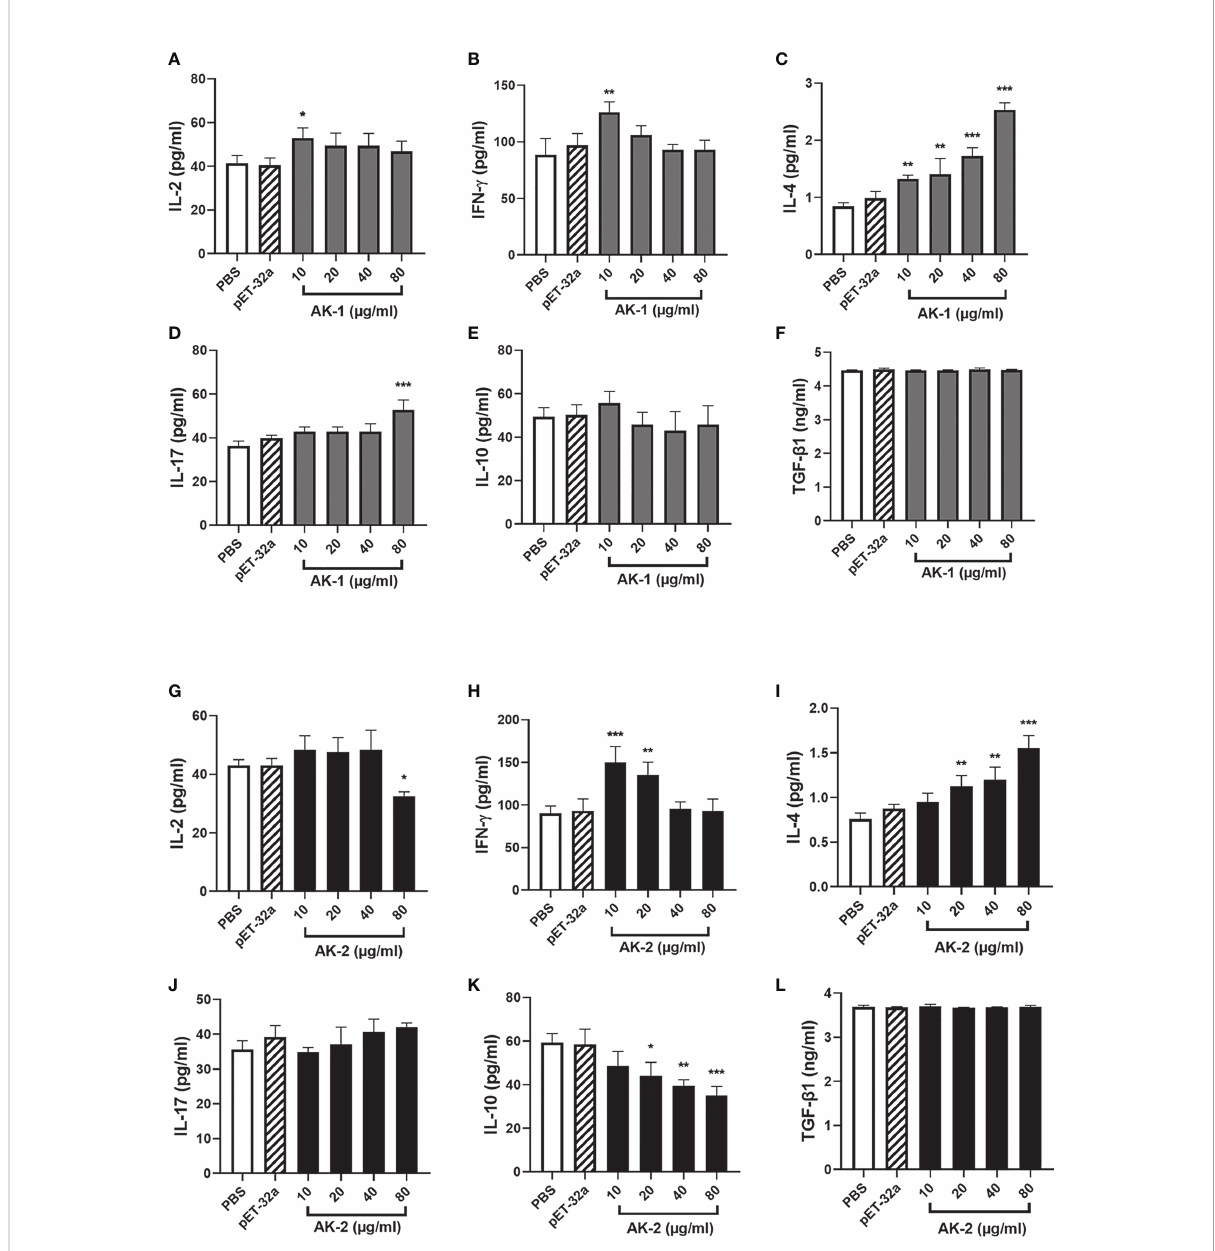
FIGURE 10 ELISA results of the effects of the rSsAKs on Th1, Th2, Th17, and Treg cytokine secretion levels. (A-F) The effect of rSsAK-1 on Th1 (IL-2, IFN- g ), Th2 (IL-4), Th17 (IL-17), and Treg cytokine (IL-10, TGF- b 1) secretion levels. (G-L) The effect of rSsAK-2 on Th1 (IL-2, IFN- g ), Th2 (IL-4), Th17 (IL- 17), and Treg cytokine (IL-10, TGF- b 1) secretion levels. Data are the mean ± SD of three replicates per group as compared to the PBS group. * P < 0.05, ** P < 0.01, *** P <